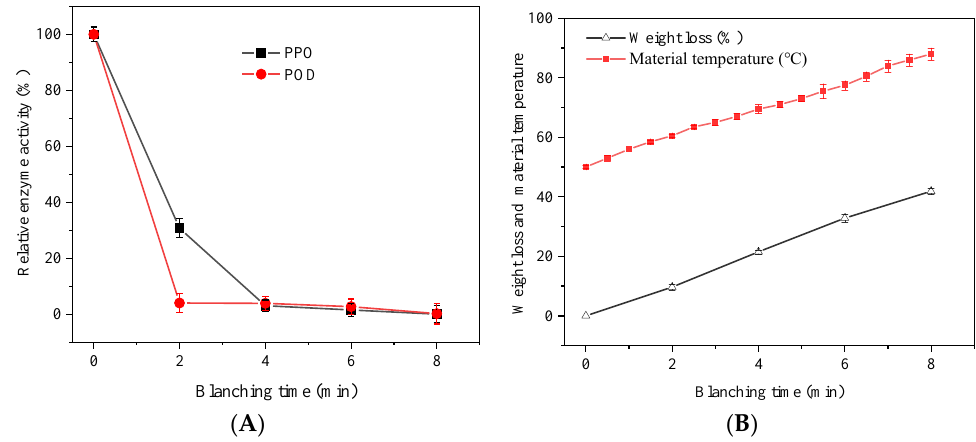
Figure 2. Changes in enzyme activity ( A ) and changes in weight loss and material temperature ( B ) in A. sessiliflorus fruits blanched for different durations. PPO, polyphenol oxidase; POD, peroxidase.